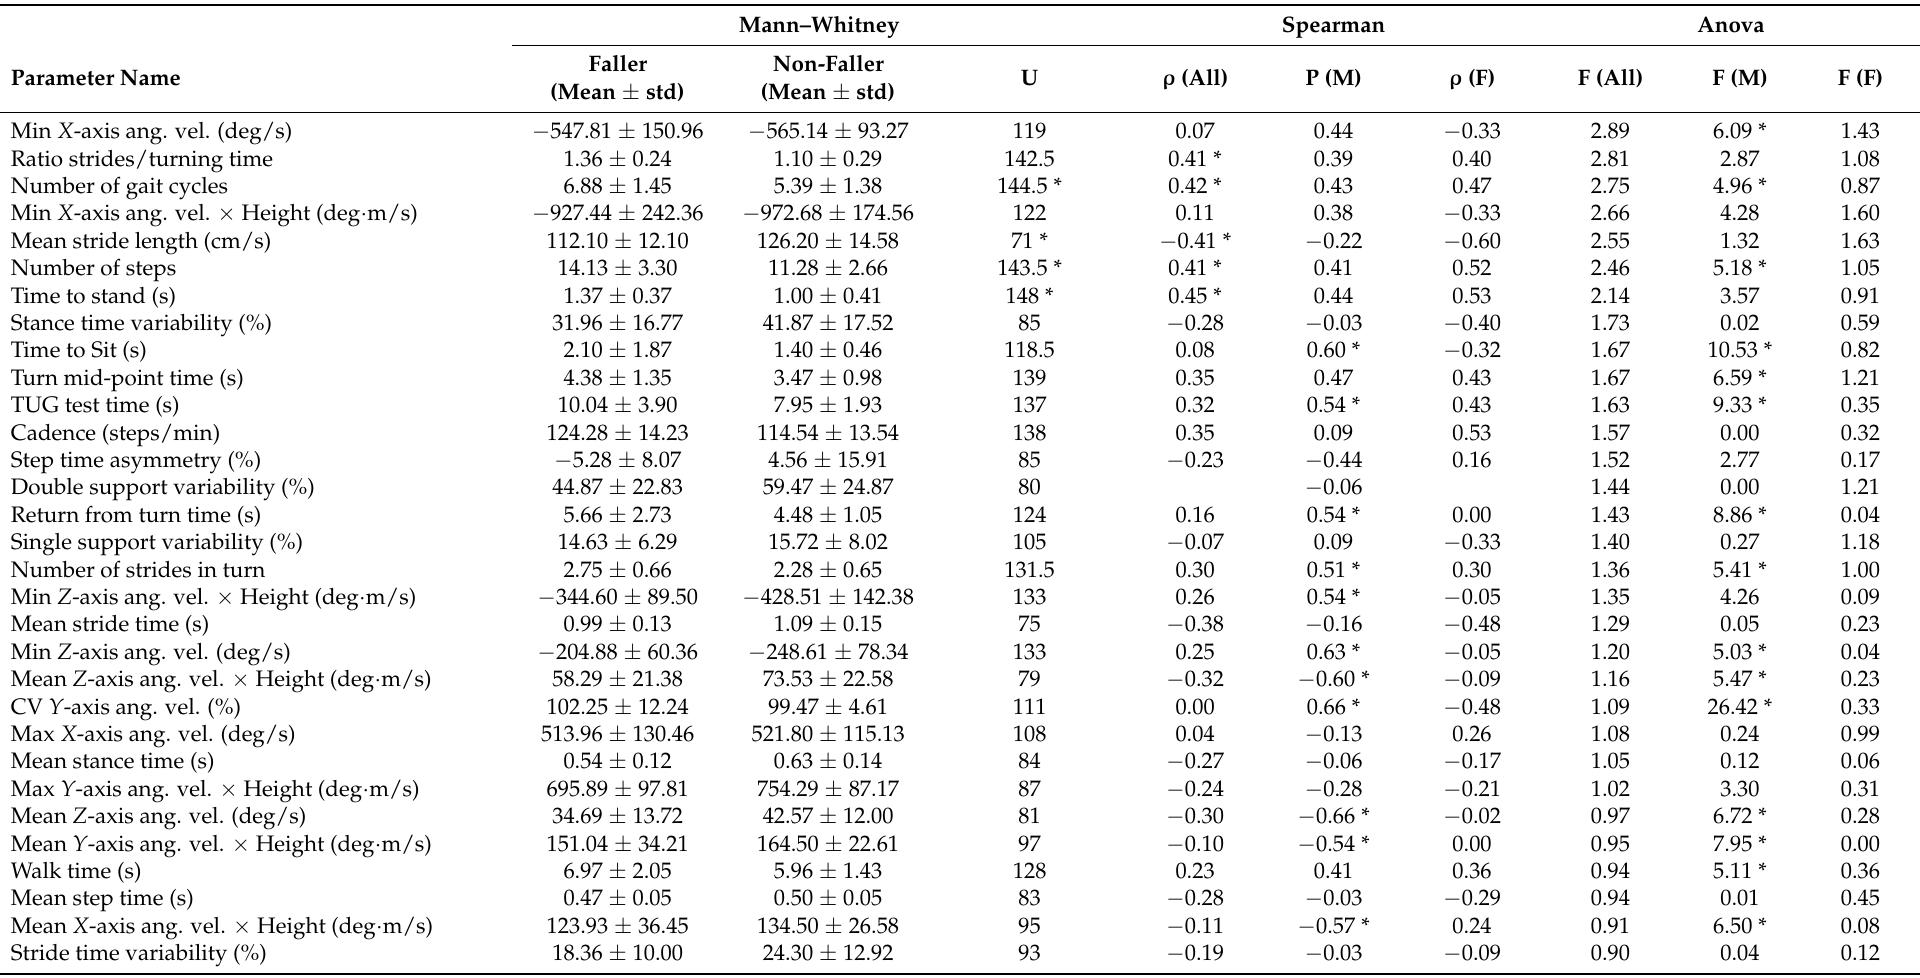
Table A4. Statistical analysis of QTUG parameters with falls counts for PD2 dataset. M and F refer to population stratified by gender. U refers to Mann–Whitney rank sum statistic, ρ refers to Spearman’s correlation coefficient, while F refers to F-score from 1-way Anova test. Statistically significant differences ( p < 0.05) are indicated by